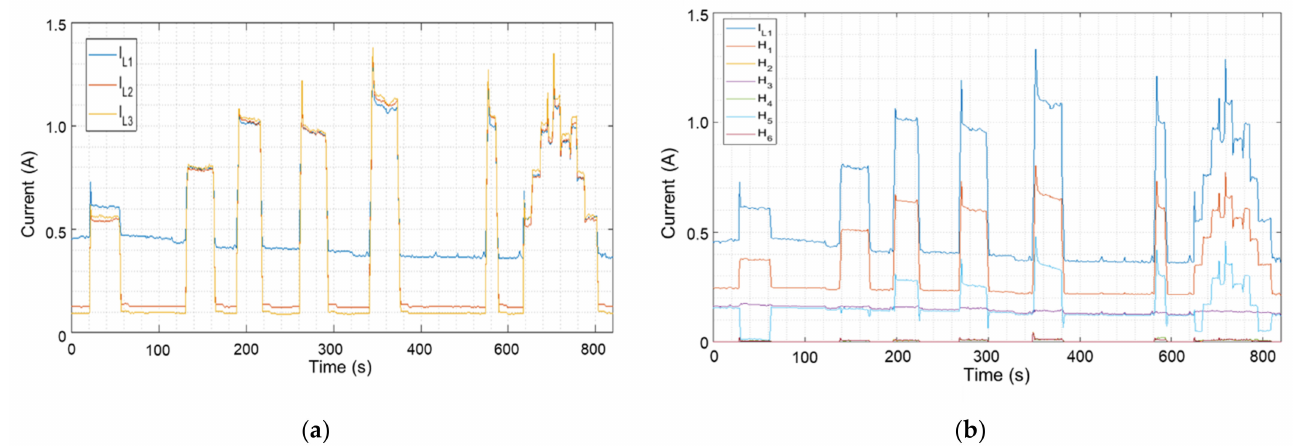
Figure 6. ( a ) Accident Proof Electrical Saw—Current trend of the saw for designated operation points. ( b ) Harmonic currents of order 1–6 for different operating points of the accident-proof saw.